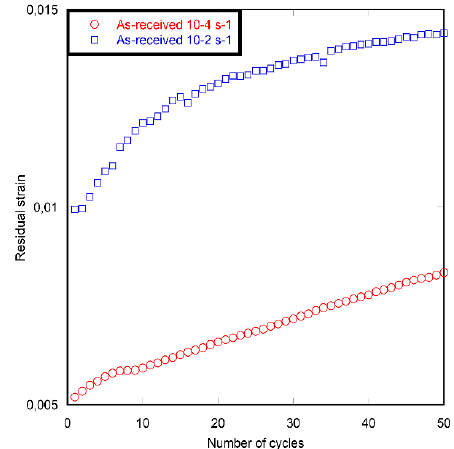
Figure 4. Residual strain rates at zero stress as a function of number of cycles of as-received specimen with imposed strain rates of 10 − 4 s − 1 and 10 − 2 s − 1 .